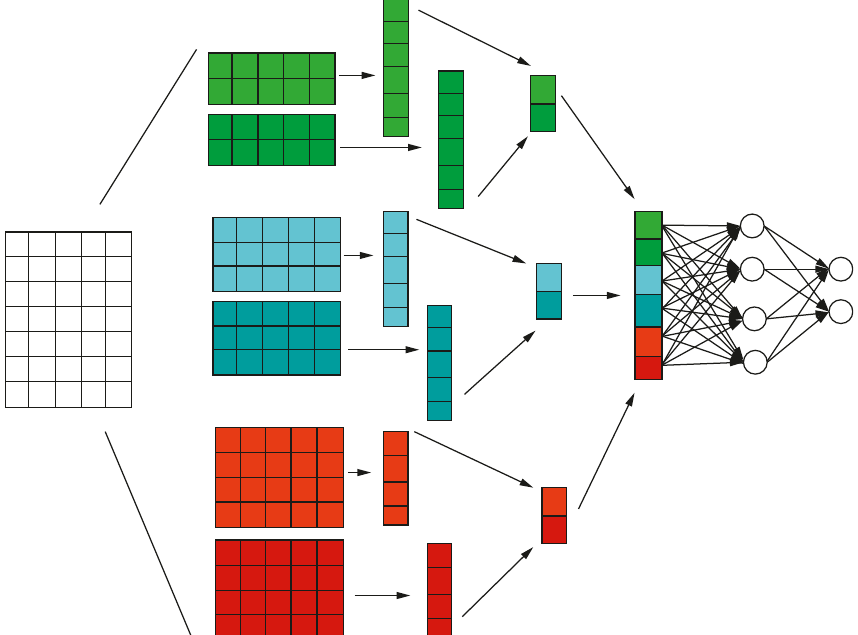
Figure 3: ConvLSTM network structure